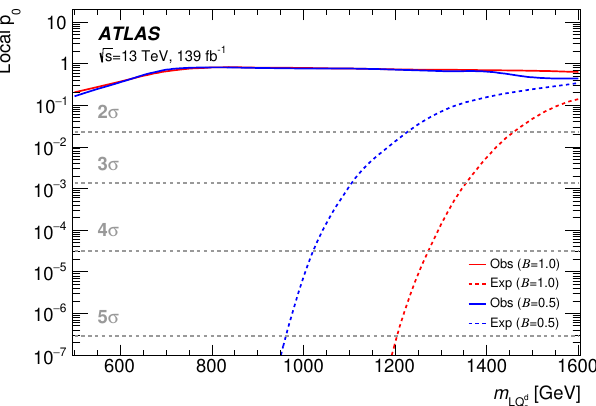
Figure 14. The observed (solid) local p 0 as a function of LQ d (blue) and B = 1 (red). The dashed curve shows the expected local p signal at that mass. The horizontal dashed lines indicate the p -values corresponding to significances of 2 to 5 standard deviations.